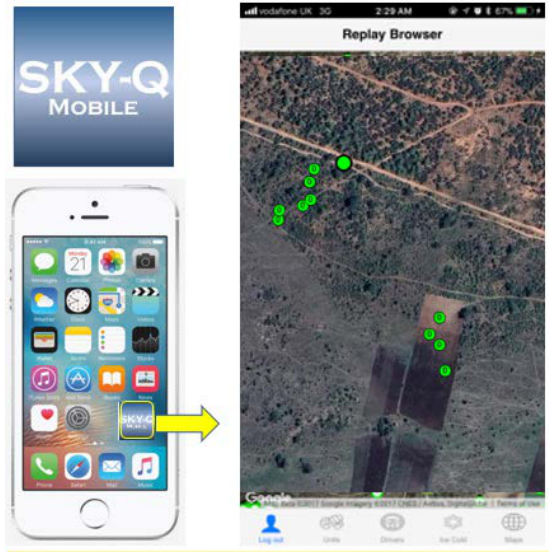
Figure 5 . Bull 15 movements and behaviours such as breaking fences and raiding crops in communal lands are monitored on mobile devices.